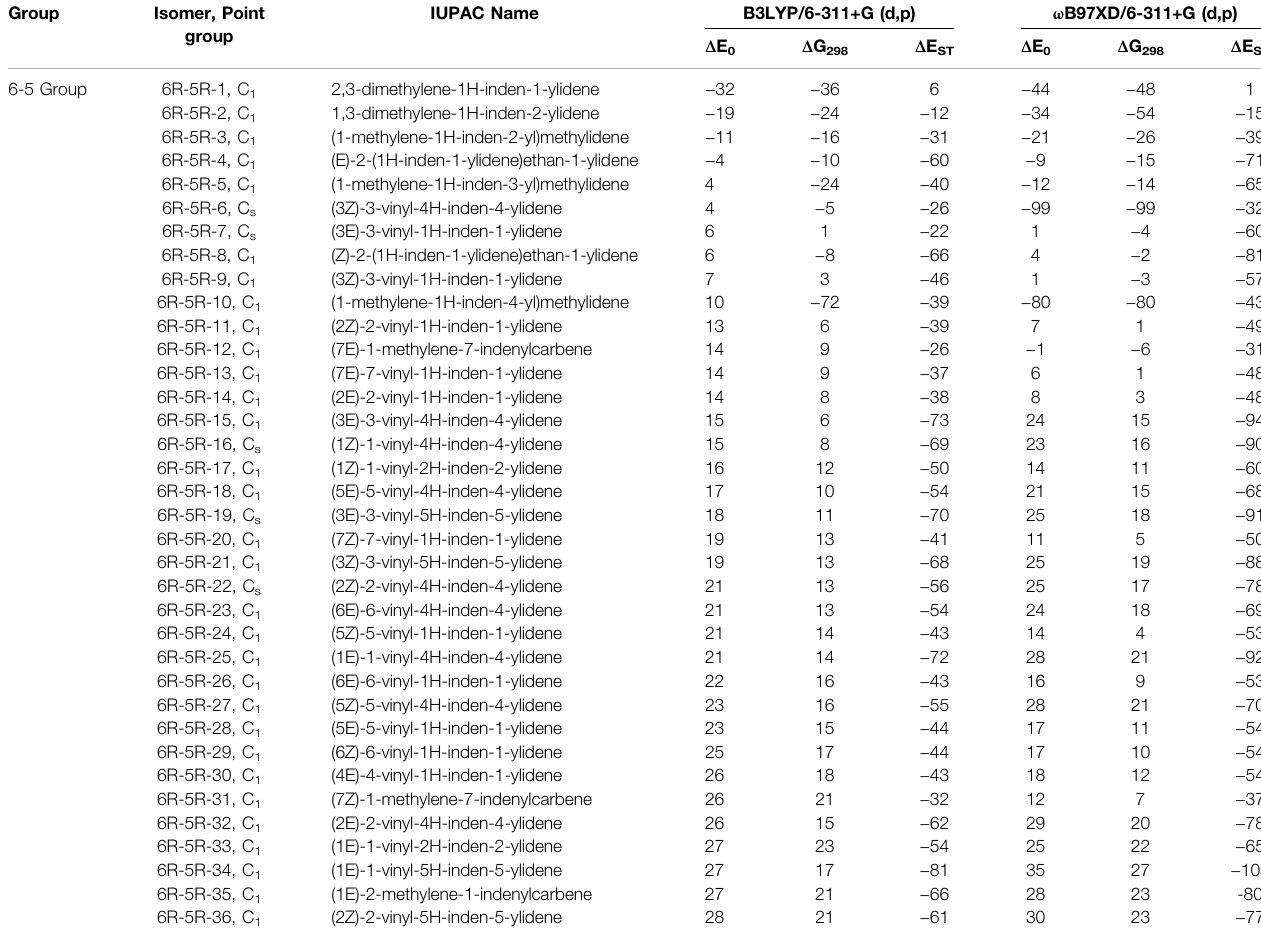
TABLE 3 | Same as Table 1 , low-lying C 11 H 8 isomer of (6R-5R) Group within ~30 kJ mol − 1 energy range calculated at different levels.